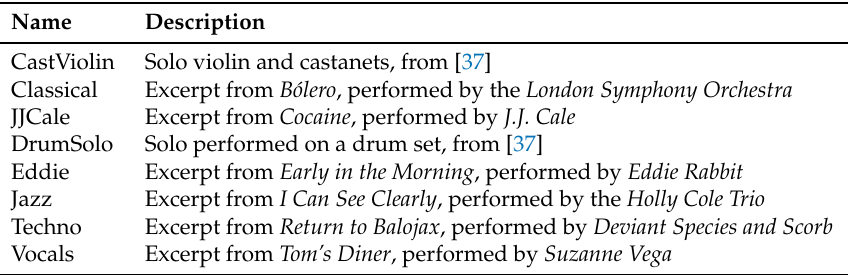
Table 1. List of audio excerpts used in the subjective listening